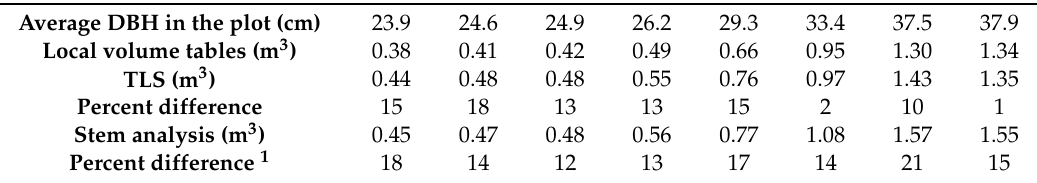
Figure 3 . Percent difference in total volume prediction as compare with local volume table data. Table 8. Predicted total volume, including bark, ranked by